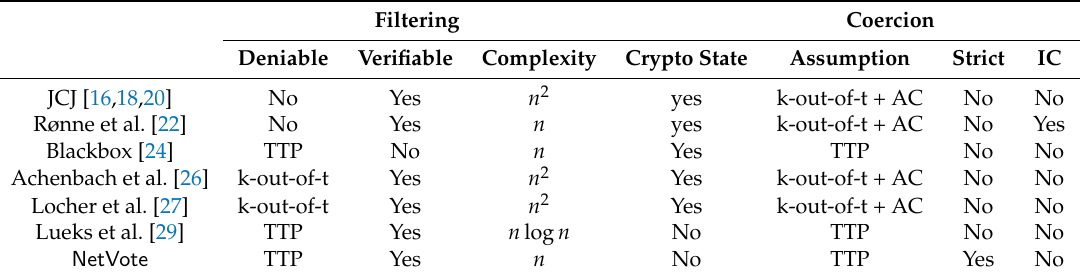
Table 1. Comparison of existing schemes. NetVote constitutes the first re-voting scheme with linear complexity, which is verifiable and does not depend on immature cryptography (IC). We introduce the new notion of strict coercion resistance to achieve linear filtering. Filtering Coercion Deniable Verifiable Complexity Crypto State Assumption Strict